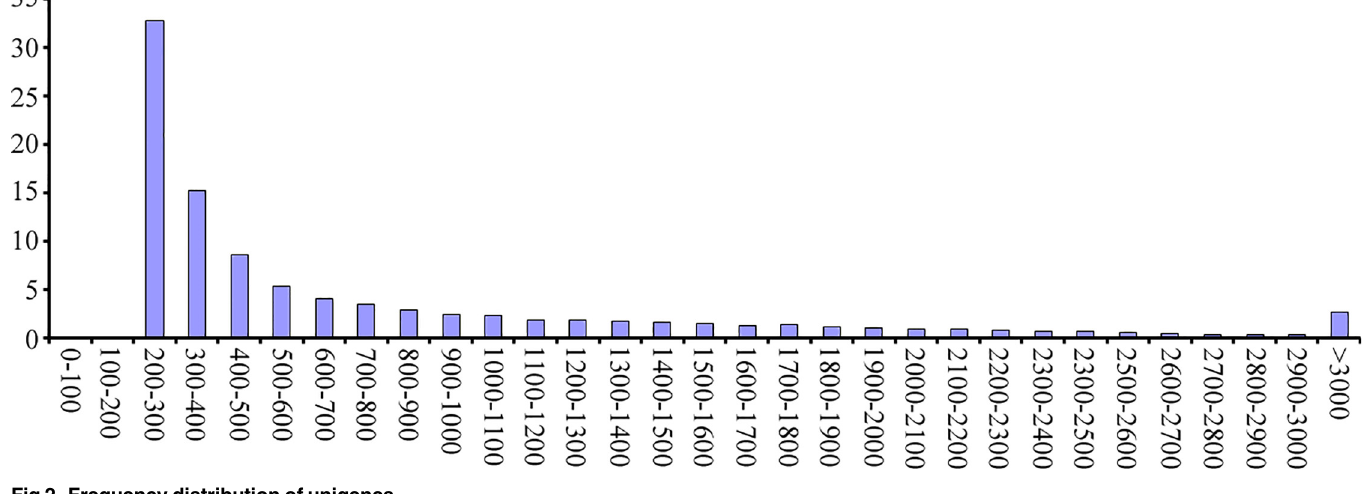
PLOS ONE | DOI:10.1371/journal.pone.0143017 November 16,